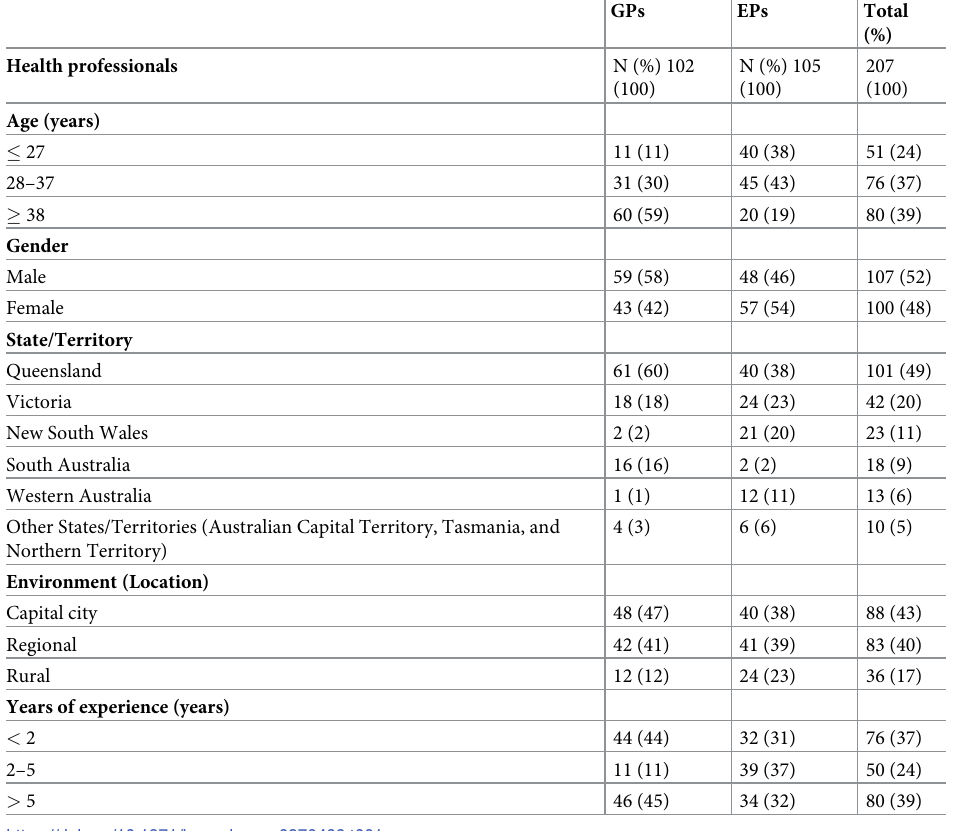
Table 1. Descriptive characteristics of participants (GPs and EPs) (N =